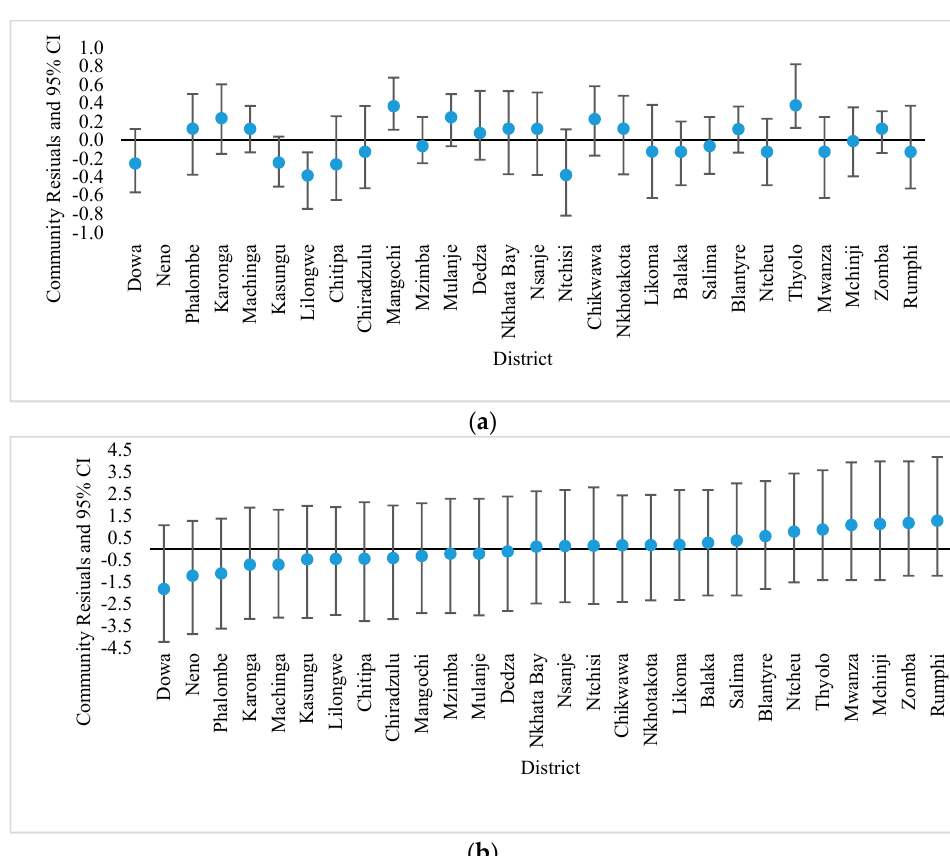
Figure 2. Caterpillar plot of random intercept predictions and 95% confidence intervals (CI) for null and full models 2015–16 MDHS.